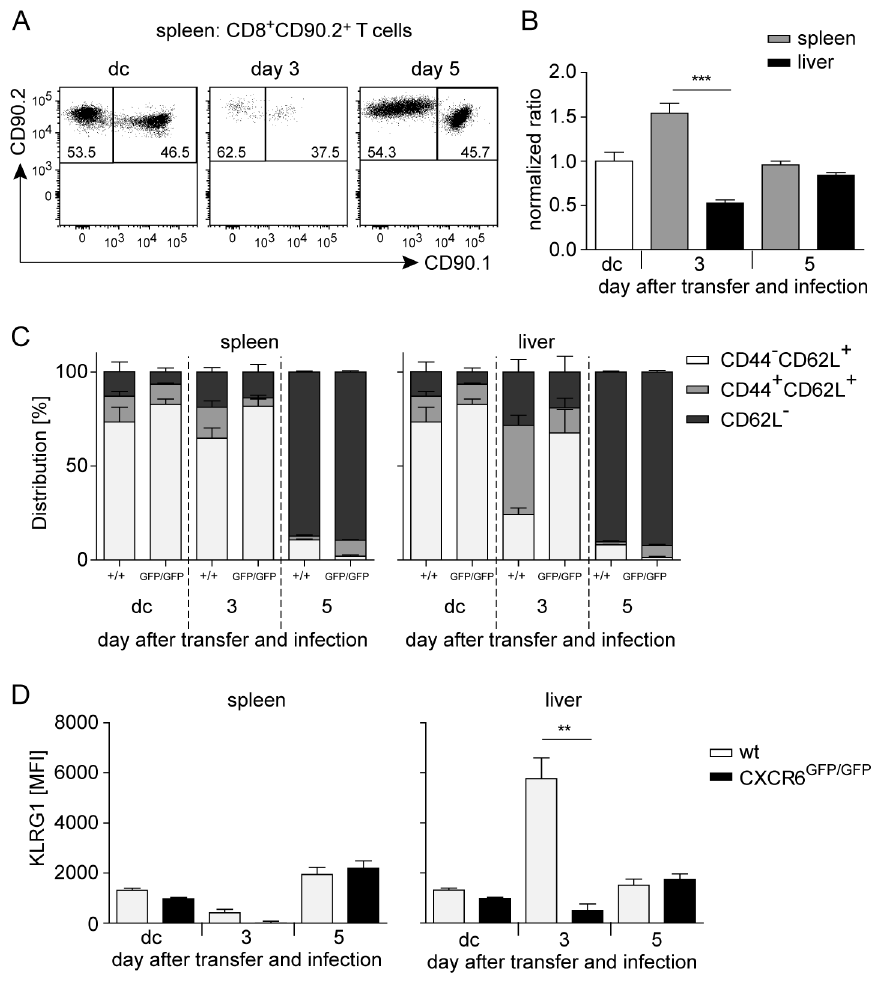
Figure 4. CXCR6 controls early accumulation of activated CD8 + T cells in the liver. Purified CD8 + T cells from wt OT–I and CXCR6 GFP/GFP OT–I mice were mixed in a ratio of 1:1 and a total of 5 6 10 4 cells were injected into congenic wt mice i.v. infected with 1 6 10 5 Lm OVA. Transferred cells from spleens and livers of recipient mice were analyzed at day 3 and day 5 p.i. (A) Representative CD90.1 and CD90.2 staining of purified and mixed OT–I cells before (dc, donor cells) andthree and five days after transfer.Numbers show percentages of positive cells. (B) Normalized ratio of transferred OT–I cells in spleens andlivers of recipient mice on indicated time points. (C, D) Activation status of transferred OT–I cells. (C)Bars show distribution of CD44 2 CD62L + , CD44 + CD62L + , and CD62L 2 cells within wt and CXCR6 GFP/GFP OT–I cells. (D) Mean fluorescence intensity (MFI) of KLRG1 staining on transferred OT–I cells. Bars give mean 6 SEM, n $ 3. The experiment was repeated twice with consistent results. **, p , 0.01; ***, p , 0.001.